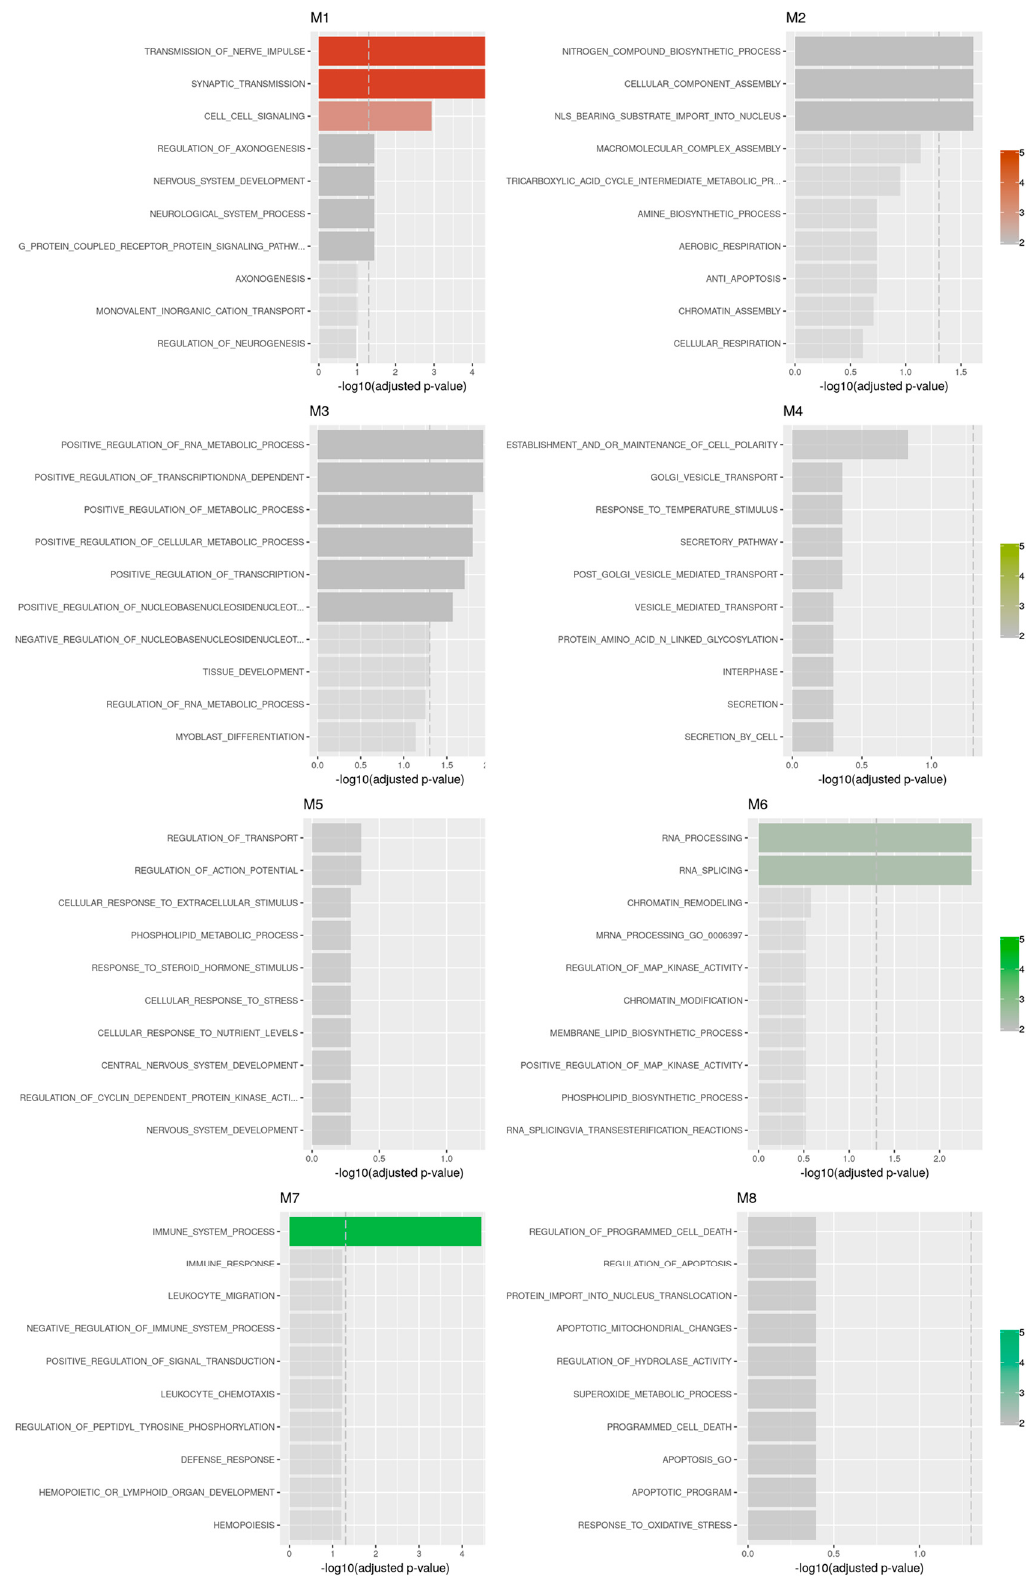
Figure 4. Biological interpretation of the gene co-expression modules obtained from the analysis of the GSE35864 dataset.